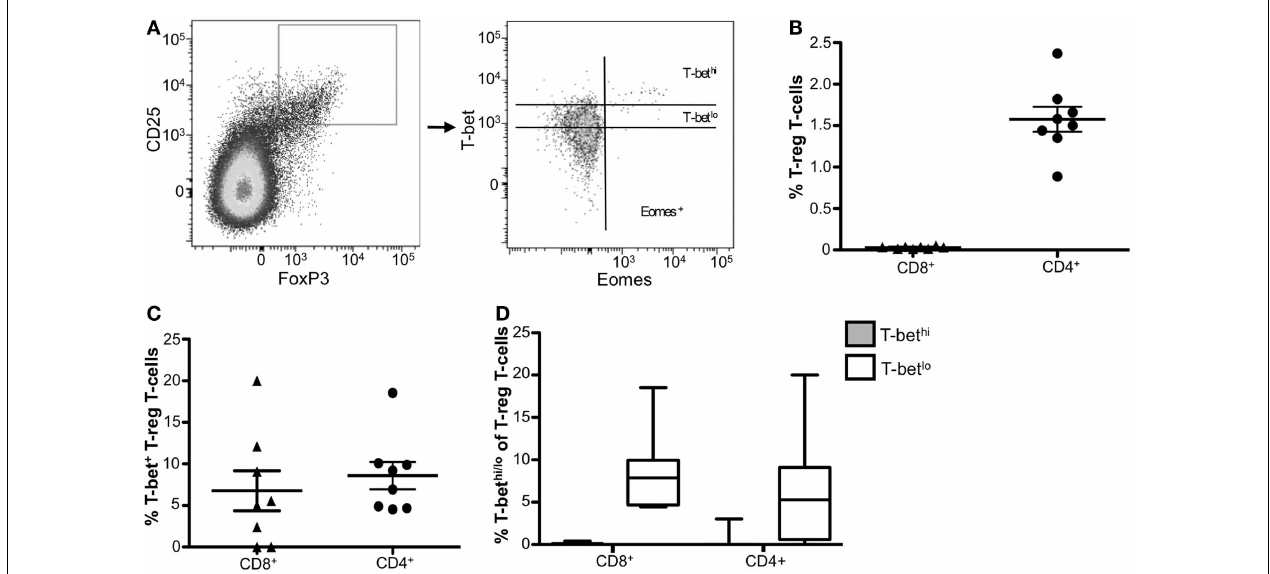
T-cells is shown. (C) The frequency ofT-bet + CD8 + and CD4 + T reg T-cells is shown. (D) Graphical representation of the mean frequency ofT-bet hi (gray) andT-bet lo (white) CD8 + and CD4 + T reg T-cells is shown.The box and whisker graphs display 25–75% (box) and 10–90% (whisker).The line in the box represents the median value. * p < 0.04, ** p <